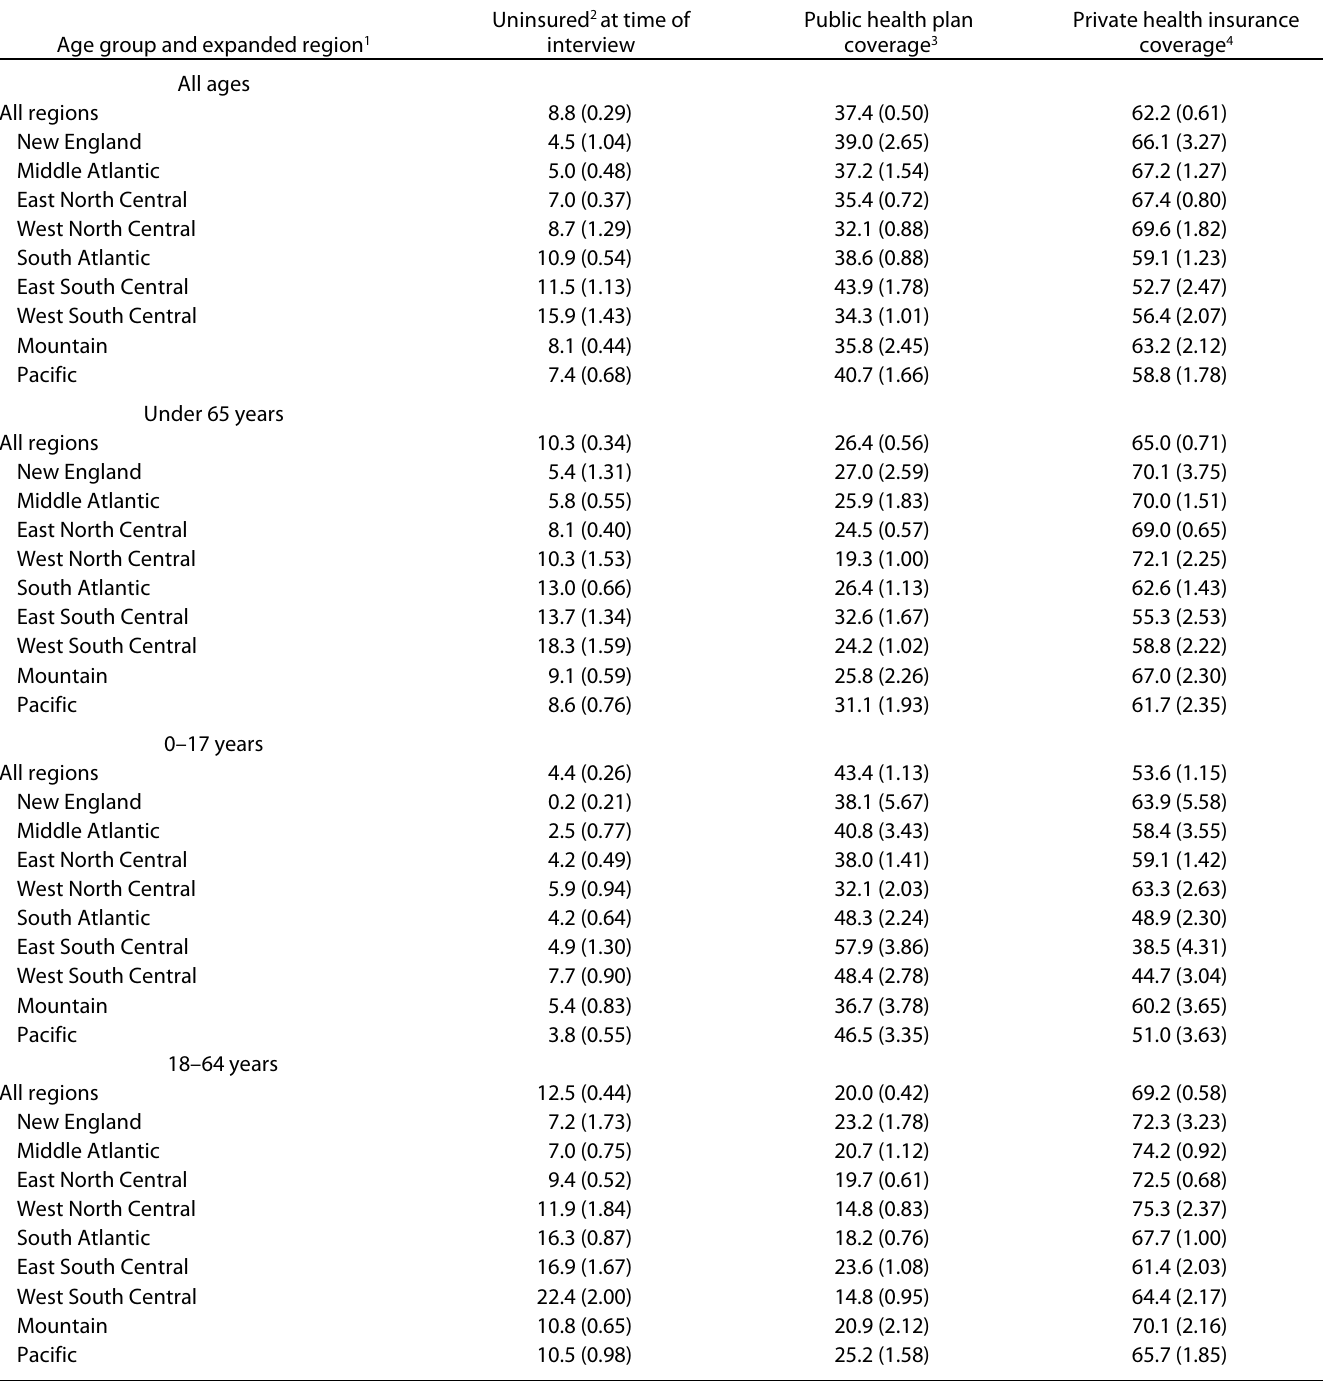
Table XV. Percentages (and standard errors) of persons who lacked health insurance coverage, had public health plan coverage, and had private health insurance coverage at the time of interview, by age group and expanded region: United